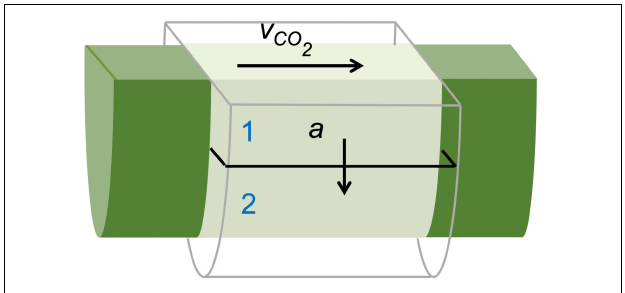
FIGURE 8 | Schematic of a simplified compartmental model used to describe xylem-dissolved 11 CO 2 -tracer movement in a cylindrical region of interest (ROI) within a branch segment shown in Figure 7A . The model is described by two parameters, i.e., xylem CO 2 transport speed v CO 2 (mm min − 1 ) and exchange fraction a (min − 1 ) as defined by Eqs. (S3–4) ( Supplementary file 2 ). Through sap flow, 11 CO 2 enters and moves through the xylem conduits (i.e., compartment 1) of each ROI with transport speed v CO 2 . Within each ROI, 11 CO 2 can move from the xylem to surrounding chloroplast containing cells (i.e., compartment 2) through a , where it is assimilated by woody tissue photosynthesis and